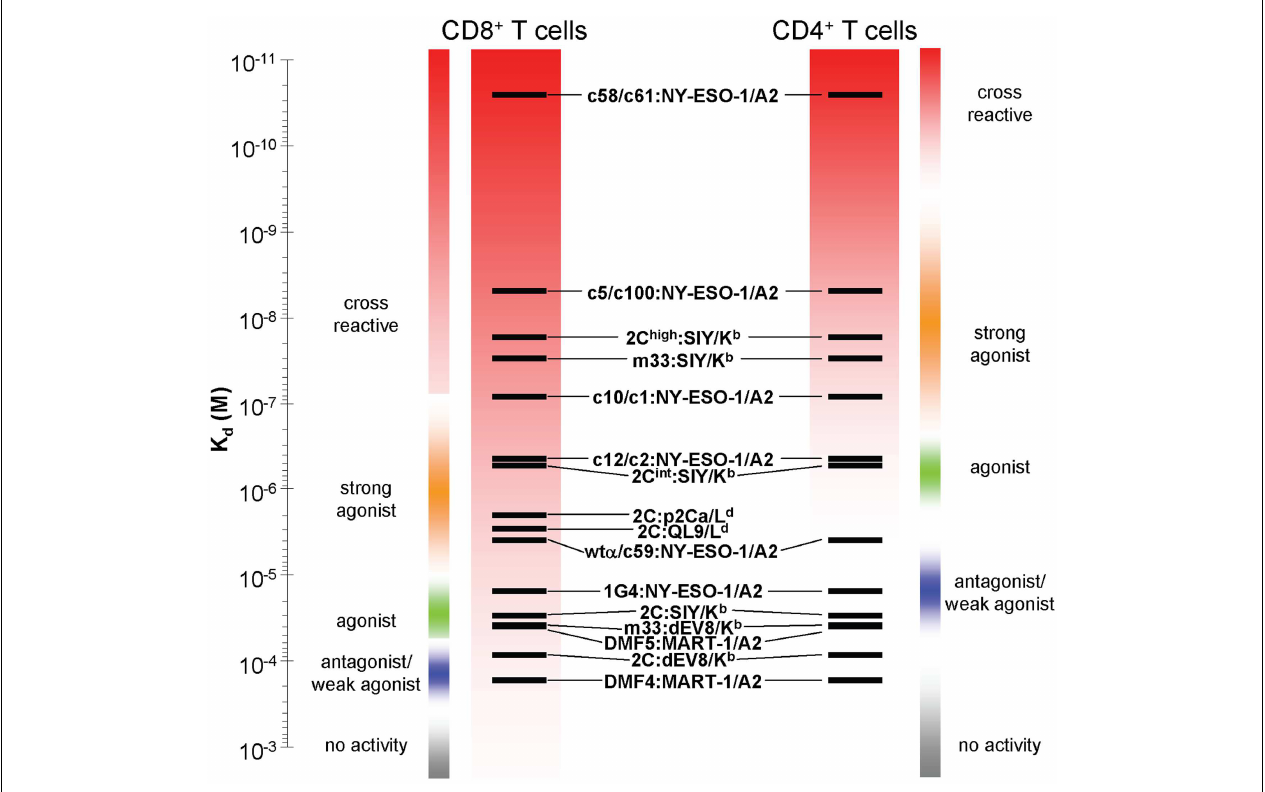
CD4 (right)T cells.The activity boundaries are approximated from the best-known systems. Sensitivity at lowTCR affinities is achieved due to TCR synergy with the CD8 co-receptor.This same principle can yield CD8-dependent, undesirable cross reactivities with structurally similar